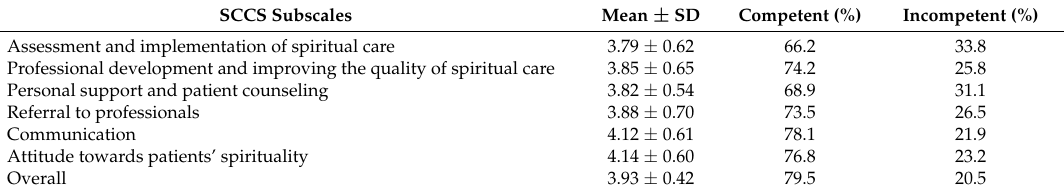
Table 3. Spiritual Care Competency Scale (SCCS) mean subscale scores and proportion of